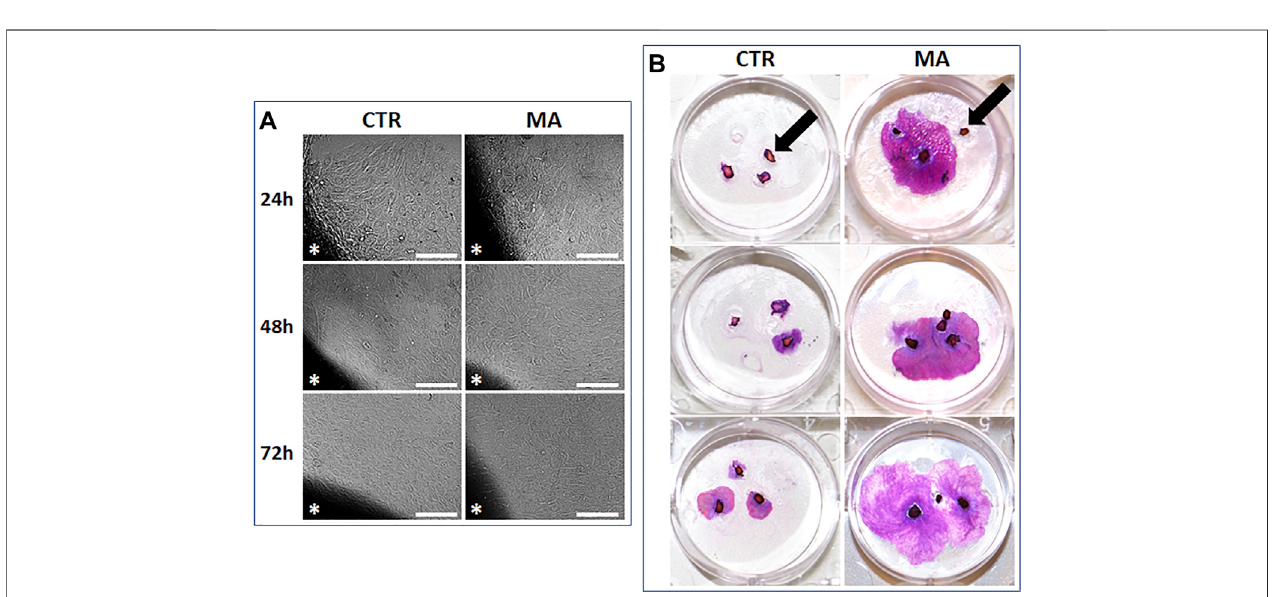
FIGURE 4 | Generation of primary cultures of human skin keratinocytes using the explant technique (small tissue fragments were placed in direct contact with the culture surface to allow cells to migrate from the tissue to the culture fl ask). (A) : Phase contrast microscope images of primary keratinocytes migrating from the skin explants(labeledwithasterisks)totheculture surfaceineach culturecondition.Scalebars: 100 µm. (B) :Illustrative images ofskin tissue explantscultured for21 days in CTRandMAmediumataconcentrationof5 μ g/mlstainedwithhematoxylin-eosin.Someskinexplantsfailingtogenerateanykeratinocyteculturesarelabeledwith black